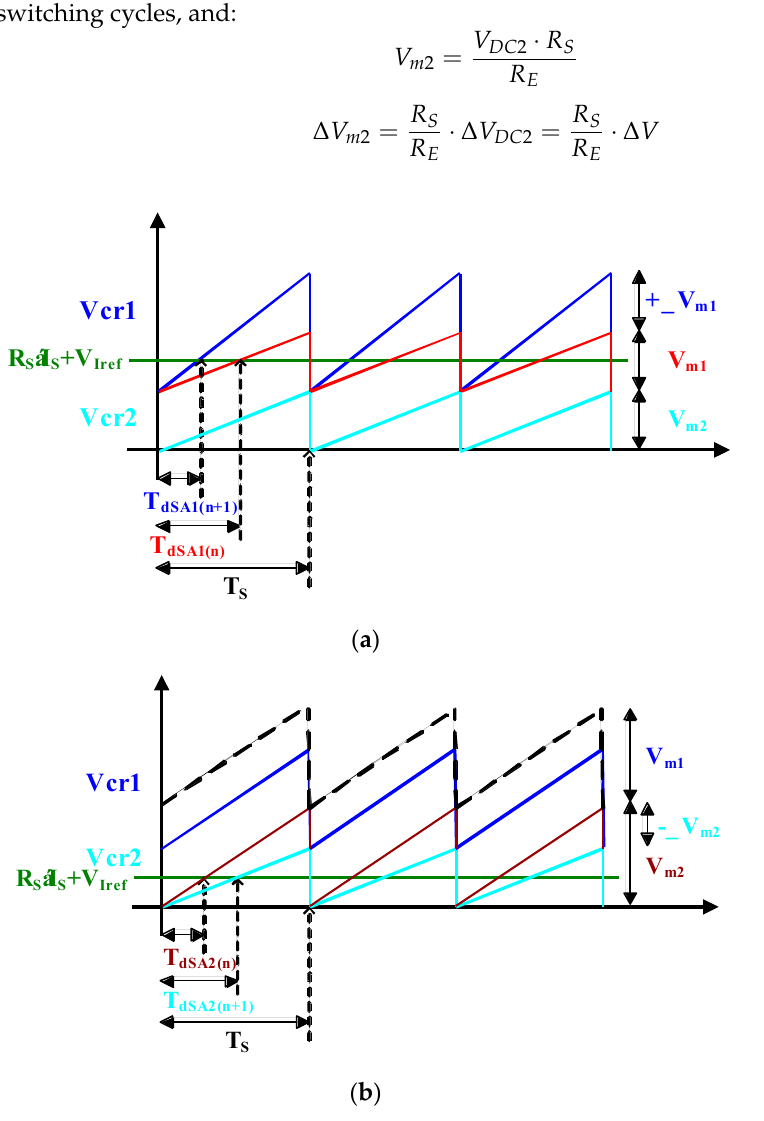
Figure 8. Proposed four-carrier level-shifted OCC PWM control of the proposed five-level OCC MV Regen-Load in region I and II. ( a ) Vcr 1 carrier signal modulation when V DC 1 > V *DC ; ( b ) Vcr 2 carrier signal modulation when V DC 2 < V *DC .